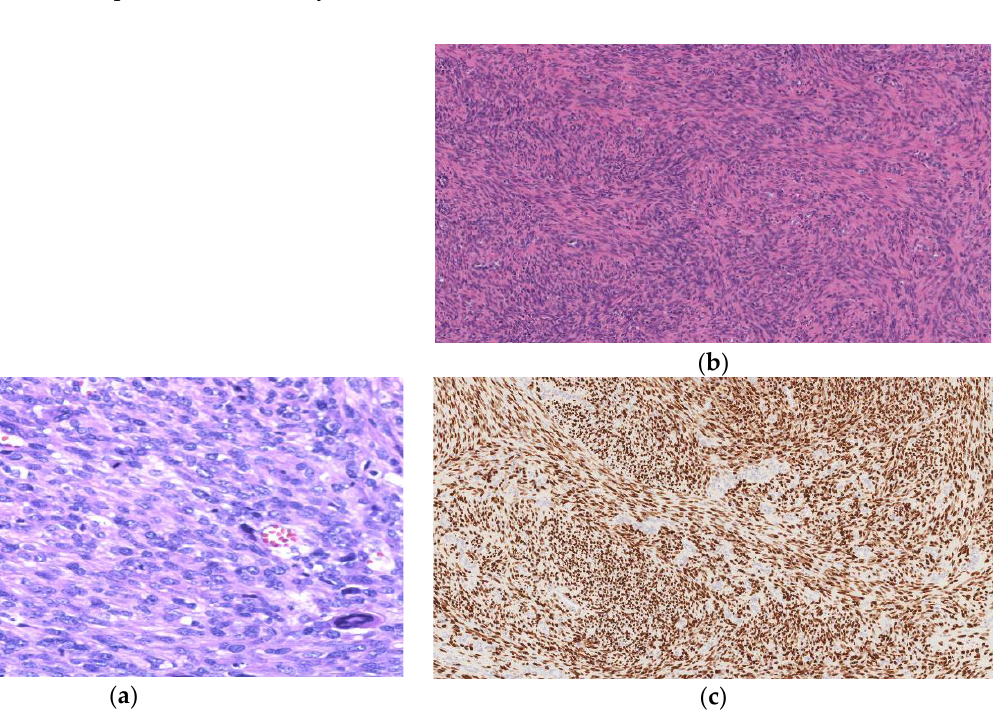
Figure 2. Photomicrographs from representative cases obtained at The Ottawa Hospital. Slides stained with Hematoxylin and Eosin (H&E) or in situ hybridization (ISH) with corresponding magnifications as follows: Leiomyosarcoma H&E 100 × ( a ) Ebstein-Barr virus-associated smooth muscle tumor (EBV-SMT) H&E 100 × ( b ) EBV-SMT positive for EBER (EBV-encoded small RNA) ISH 100 × ( c ).